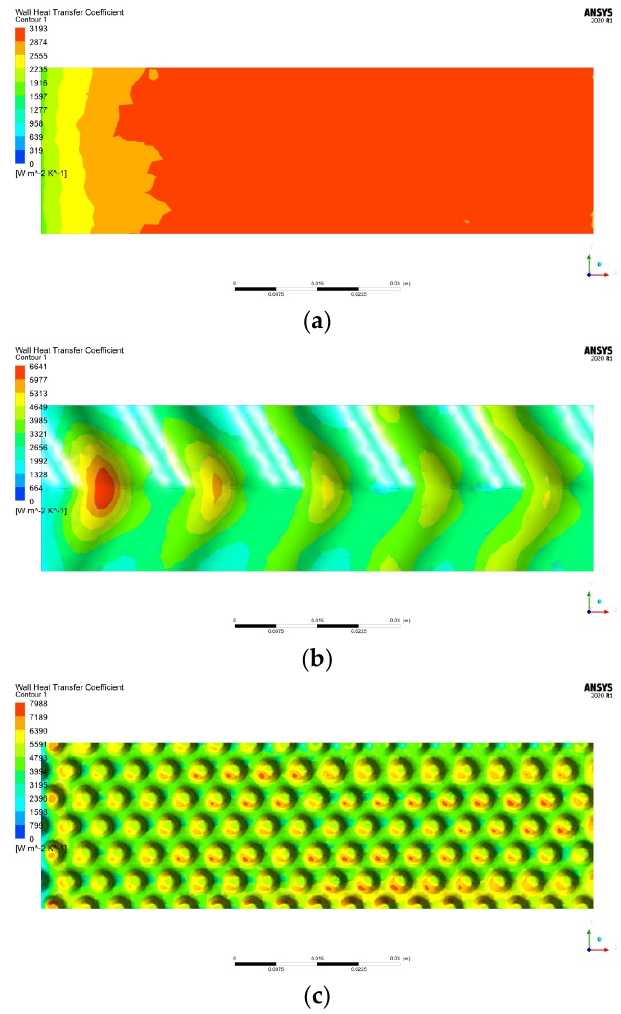
Figure 10. Contours of heat transfer coefficients: ( a ) flat heat exchange plate; ( b ) chevron heat exchange plate; ( с ) plate with conical stamping.